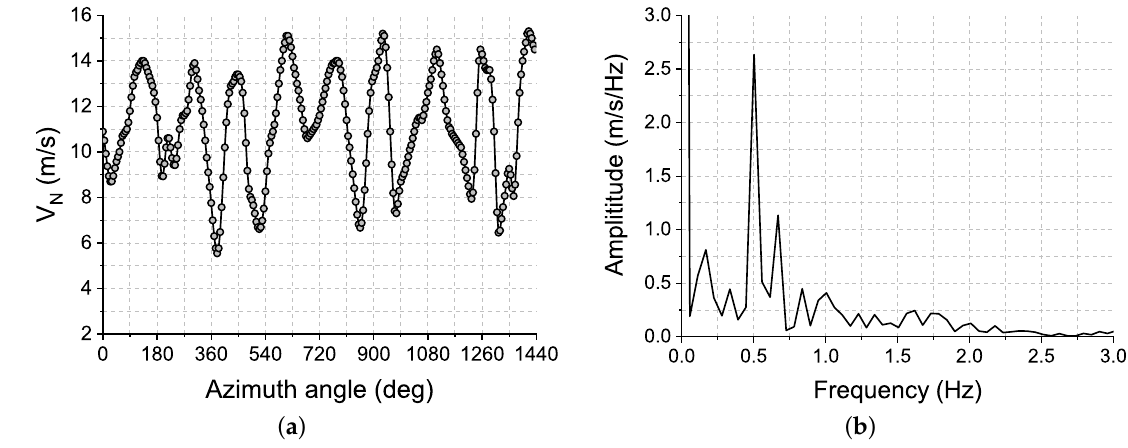
Figure 13. Variation of V N at high wind speed, 13m/s. ( a ) Time domain. ( b ) Frequency